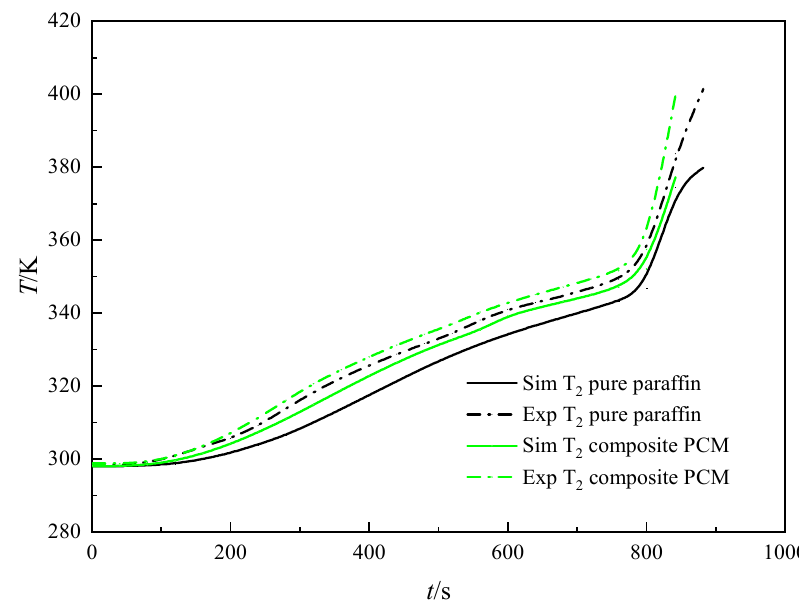
Figure 11. Temperature distribution of pure paraffin and composite PCM.